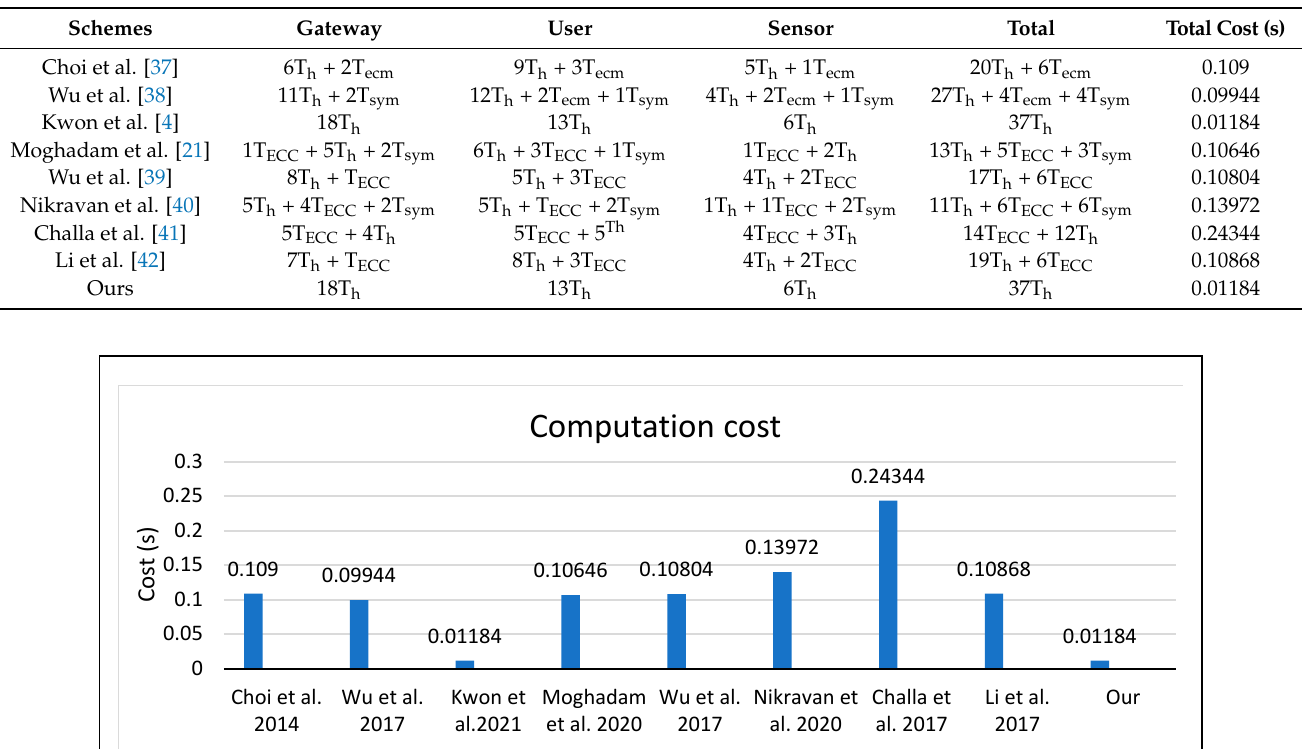
Figure 10. Total computational cost comparison